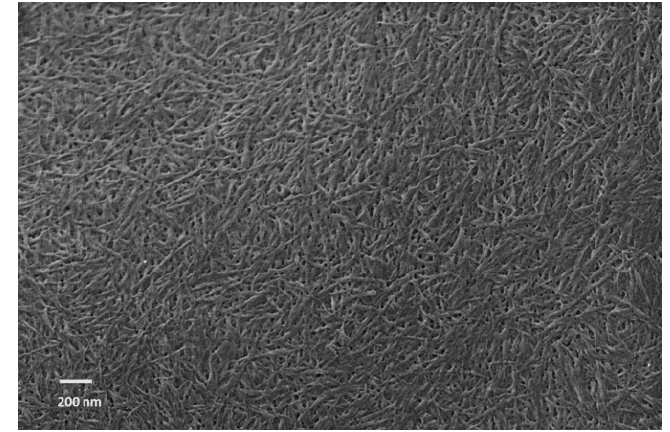
Figure 2. FE-SEM micrograph of a freeze-dried specimen of CNCs.